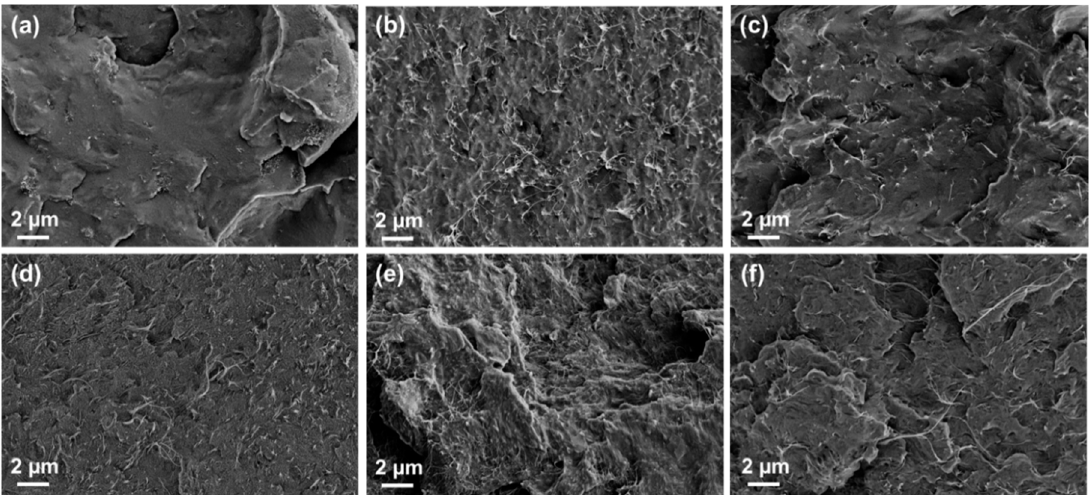
Figure 4. SEM micrographs of the cyo-fracture surface of polymer/2 wt % CNT composites: PP with MWCNT ( a ), PP with SWCNT ( b ), PP with b-MWCNT ( c ), PVDF with MWCNT ( d ), PVDF with SWCNT ( e ), and PVDF with b-MWCNT ( f ).